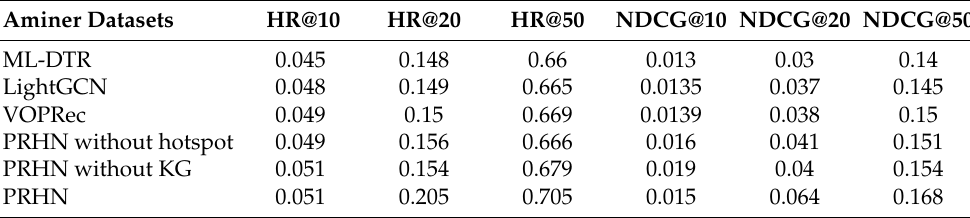
Table 2. Performance of different models on Aminer datasets.